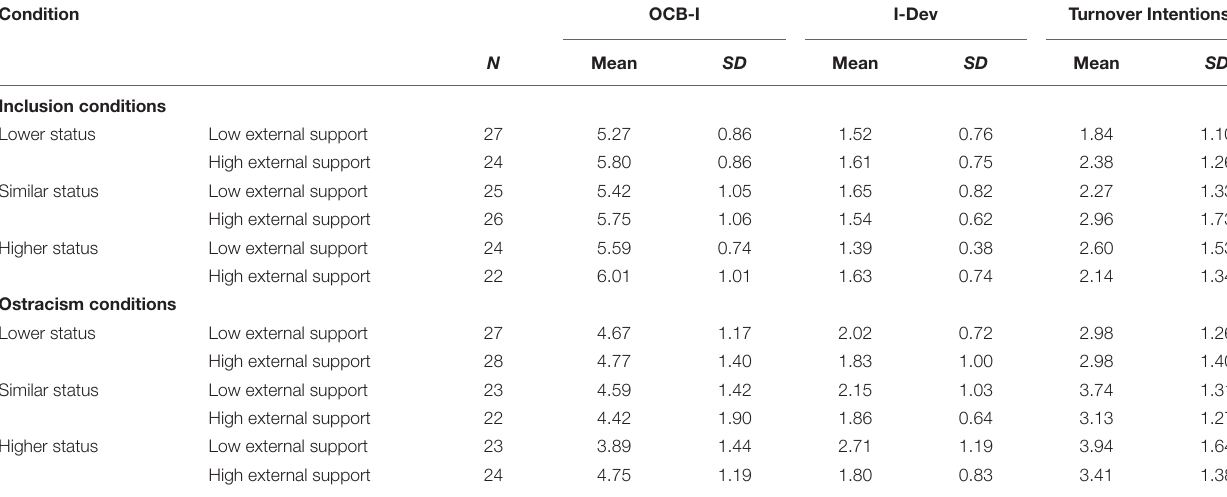
TABLE 1 | Study 1: Means for the 12 vignette scenario conditions. Condition